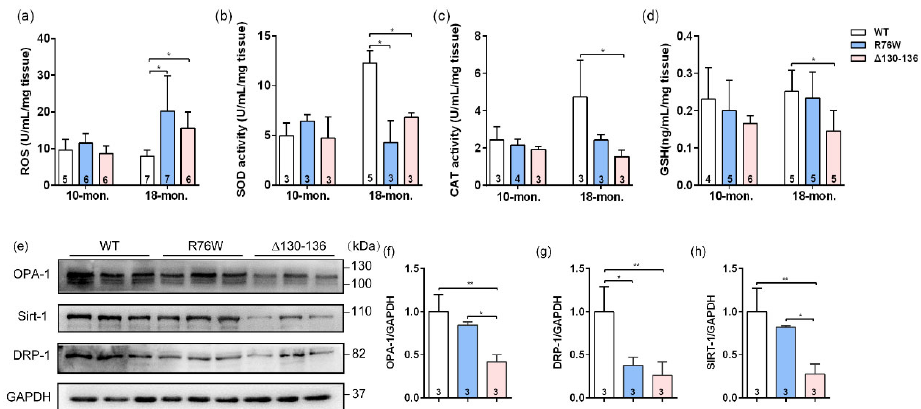
Figure 5. Effects of Cx43 channels on oxidative stress and mitochondrial homoeostasis in muscles of 18-month-old transgenic mice. ( a – d ) Levels of ROS ( a ), SOD activity ( b ), CAT activity ( c ) and GSH ( d ) in muscle of aged transgenic mice and their WT littermates. ( e ) Western blotting images of marker proteins related to muscle mitochondrial homoeostasis; ( f – g ) Quantifications of protein expression for OPA-1 (f), Drp-1 ( g ) and Sirt-1 ( h ) in ( e ). Sample sizes are indicated at the bottom of each column. * p < 0.05; ** p < 0.01.